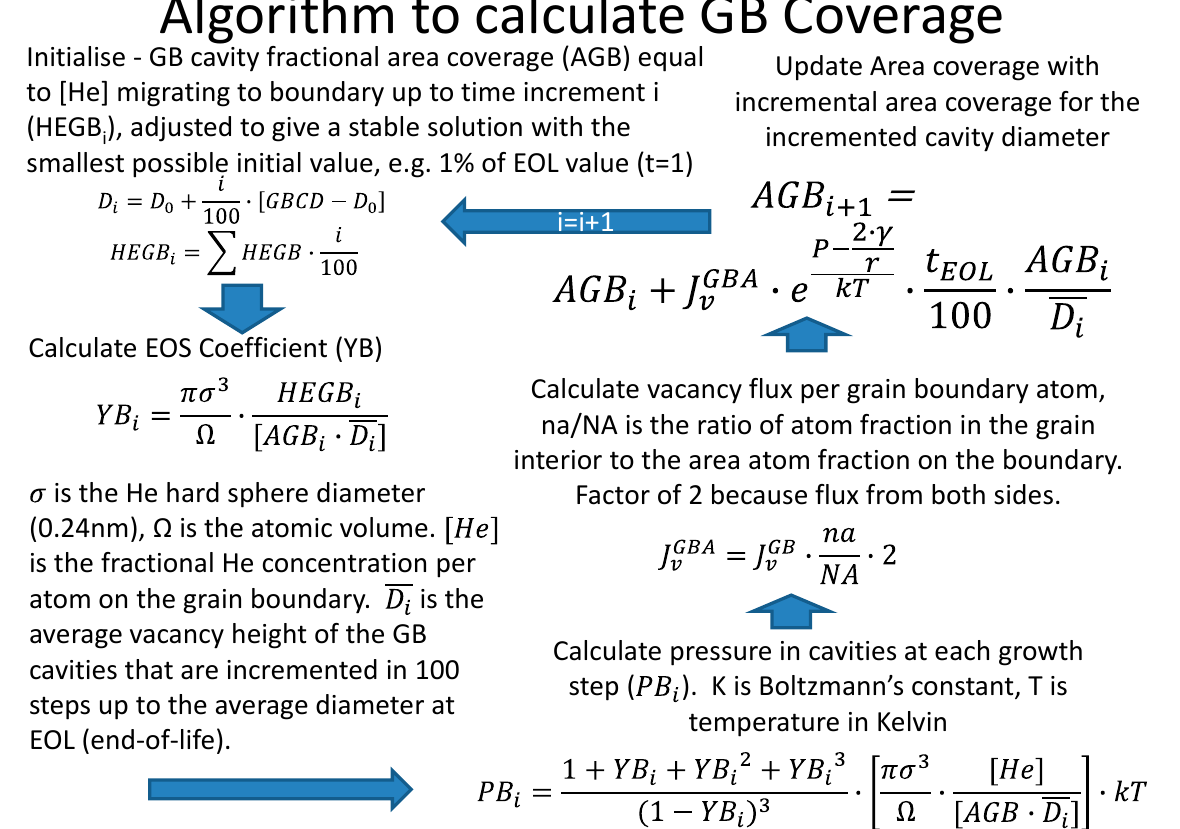
Figure 14. Algorithm describing the grain boundary cavity evolution subject to a vacancy and He flux to the boundary up to a target end-of-life (EOL) time. Grain Boundary Coverage for a CANDU Reactor Neutron Spectrum For Inconel X-750, the grain boundary coverage is calculated assuming that the grain interior microstructure can be described by either: (a) bubble evolution or (b) void evolu- tion models.